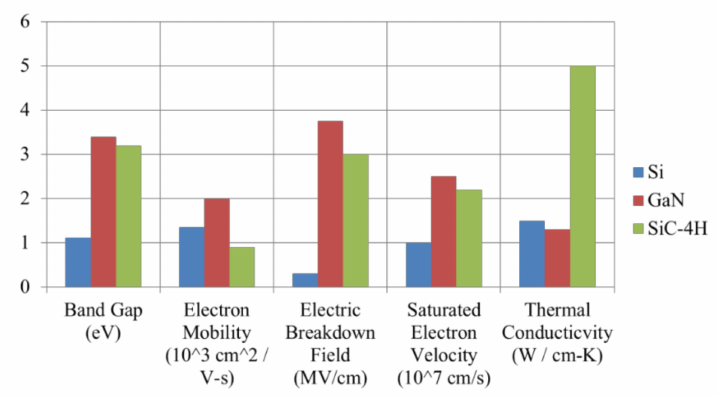
Figure 1. Comparison of Si, gallium nitride (GaN), and silicon carbide (SiC).